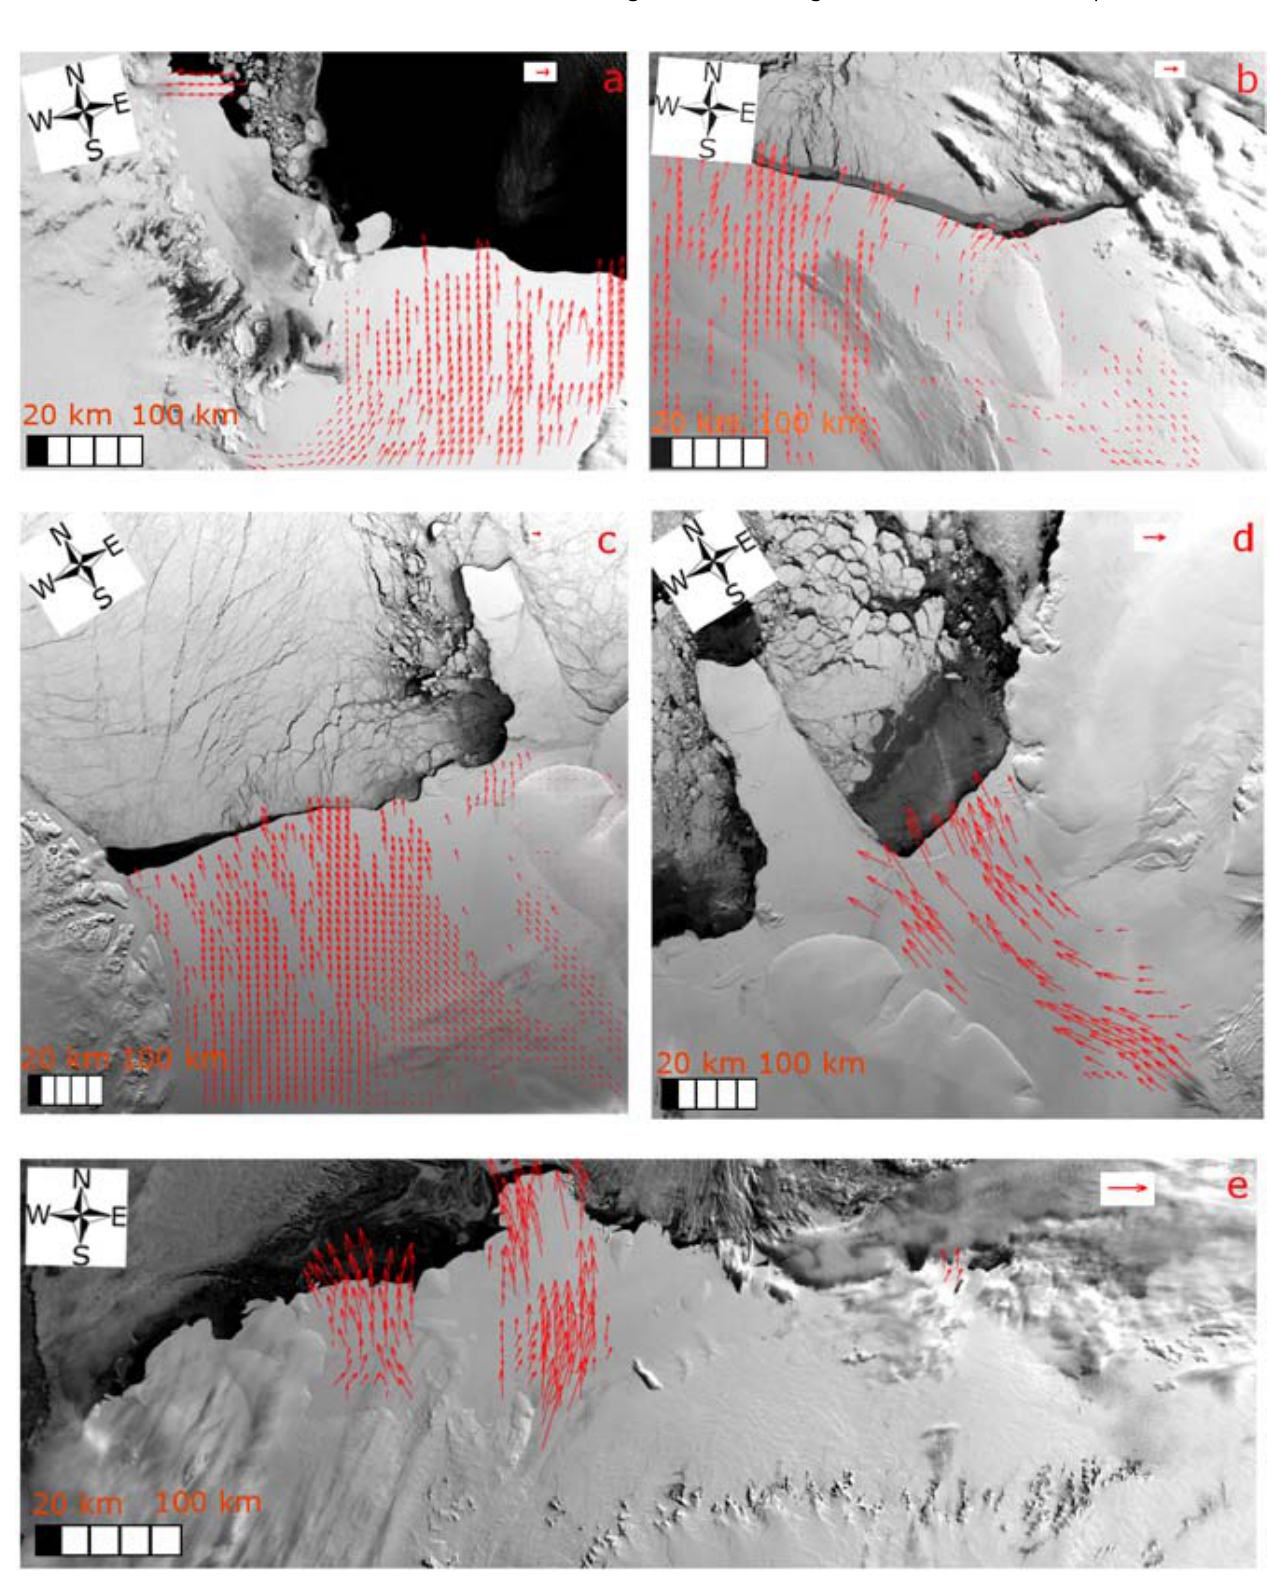
Fig. 12. The velocity fields of four ice shelves in Antarctica derived from repeat MODIS images using orientation correlation. (a) Ross (west), (b) Ross (east), (c) Ronne, (d) Filchner, (e) Fimbul. The arrow in the upper right corner indicate a velocity of 500ma − 1 . Note that the scale of the arrow changes from subfigure to subfigure. The underlying images are preprocessed by Scambos et al.